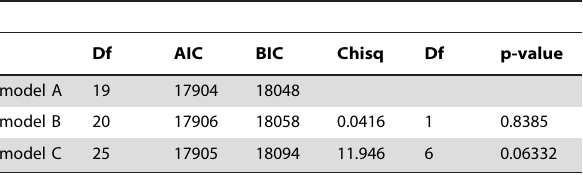
Table 2. Results of Likelihood ratio tests comparing models w/o subjective